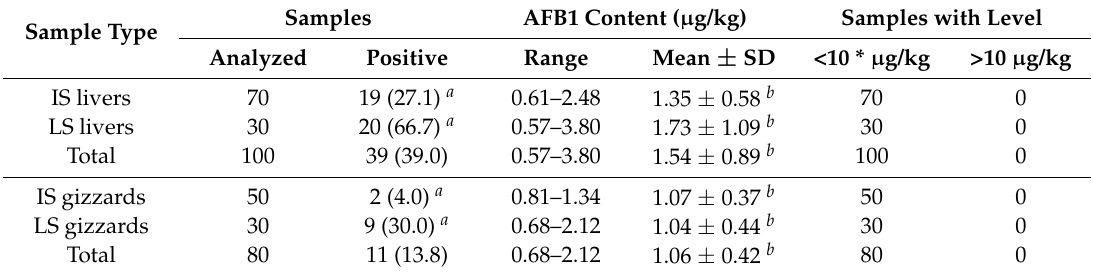
Table 3. Frequency of contamination and aflatoxin B 1 concentrations in chicken livers and gizzards.